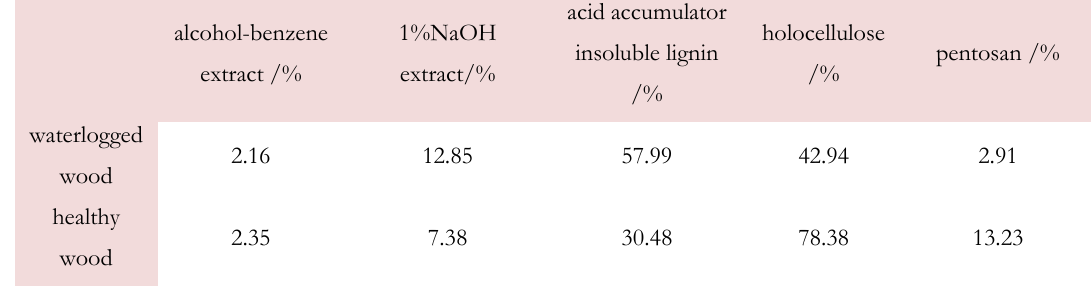
Table 4: Chemical compositions of Pinus yunnanensis ancient wood and healthy